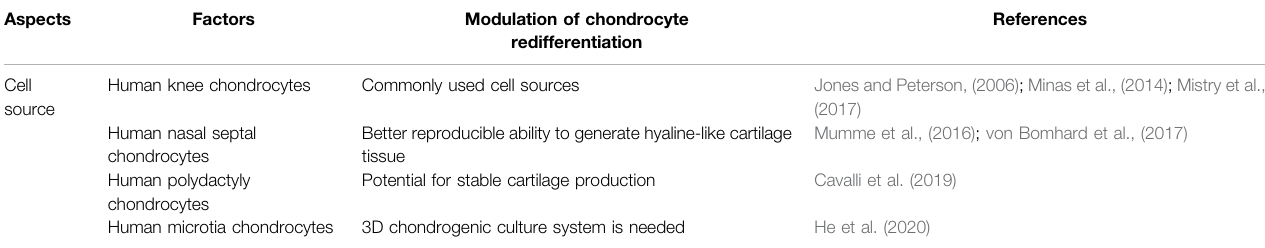
TABLE 1 | Cell source modulates the redifferentiation of